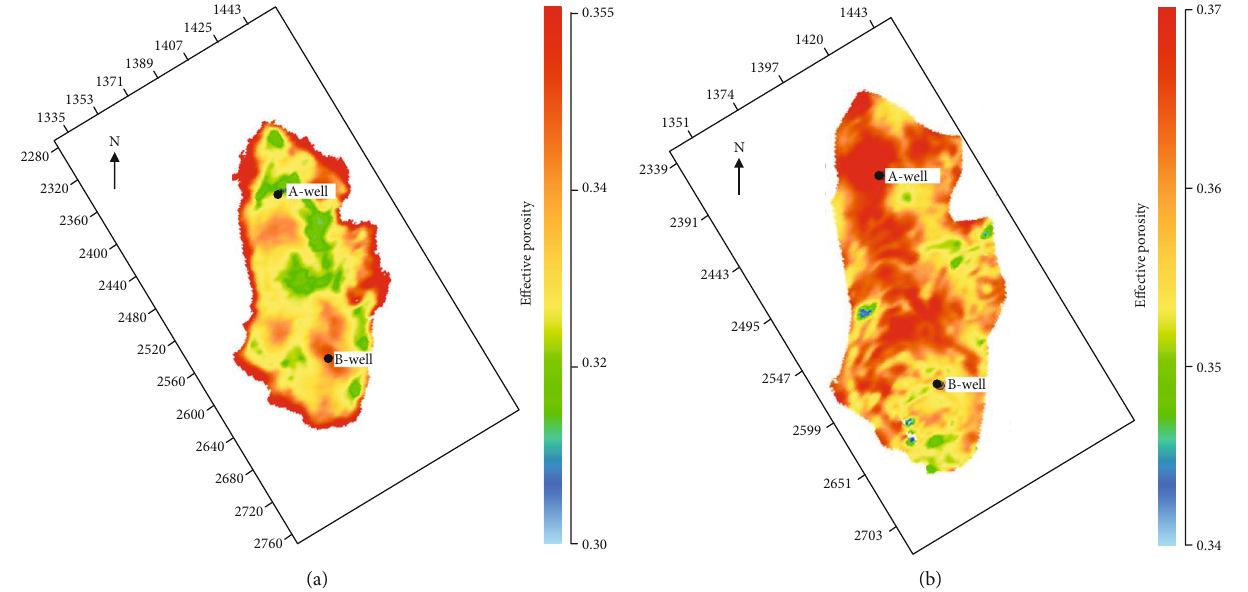
Figure 15: Plane distribution of e ff ective porosity for gas hydrate and free gas in the A-B ore body.